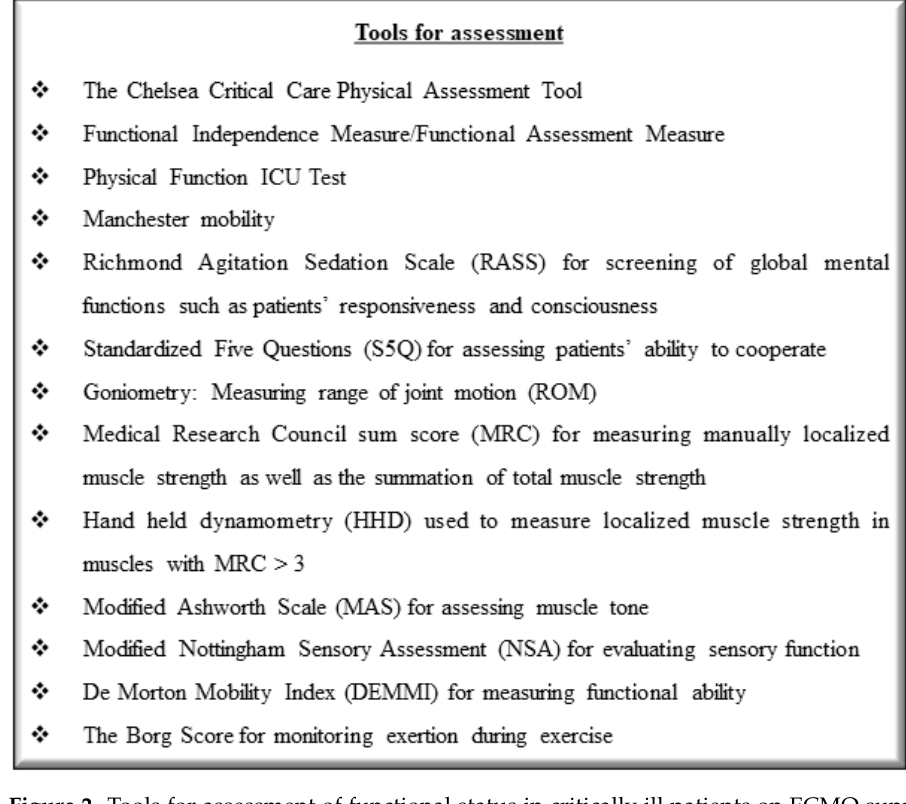
Figure 2. Tools for assessment of functional status in critically ill patients on ECMO support [79]. ECMO, extracorporeal membrane oxygenation; ICU, intensive care unit.